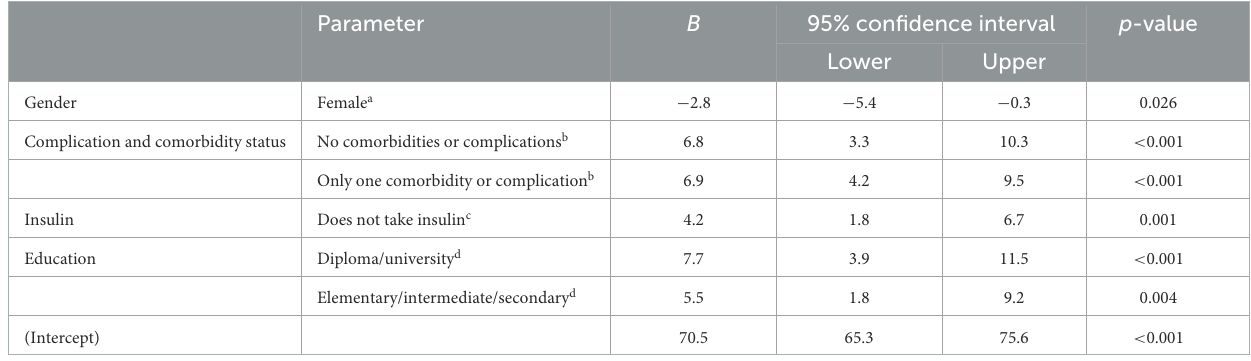
TABLE 5 VAS score regression model.